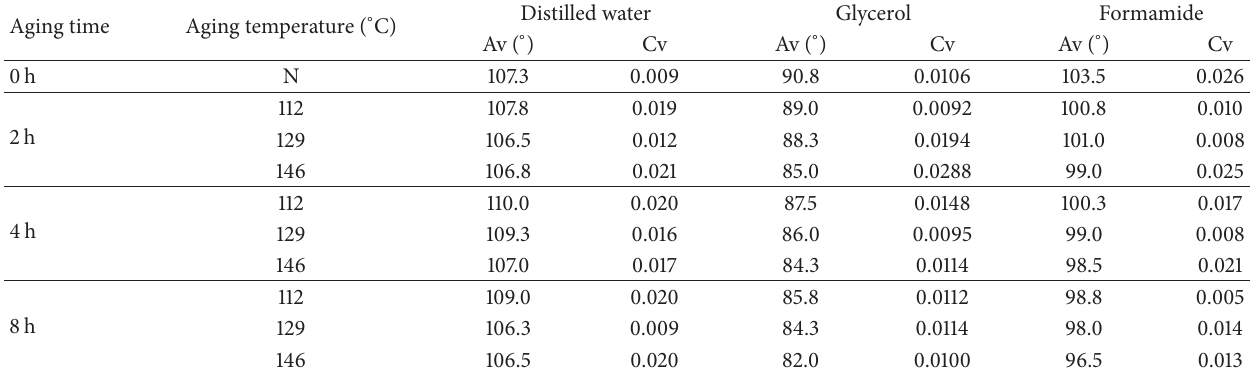
Table 5: Average contact angles of RTFO aged asphalt binders with WMA additives (22 ∘ C). Aging